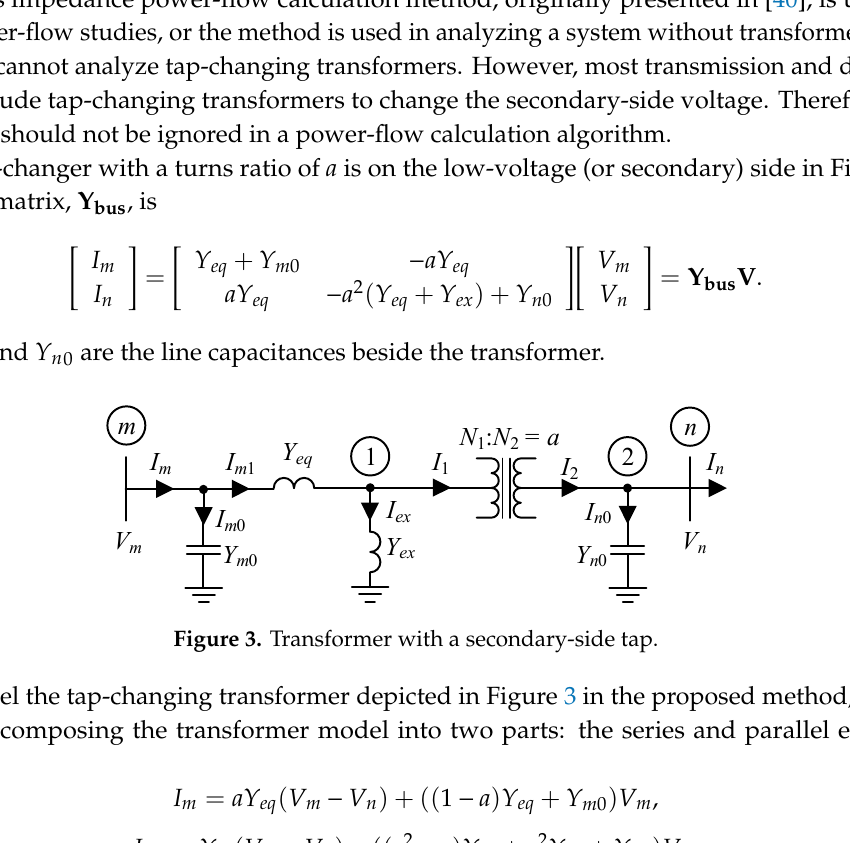
Figure 3. Transformer with a secondary-side tap.